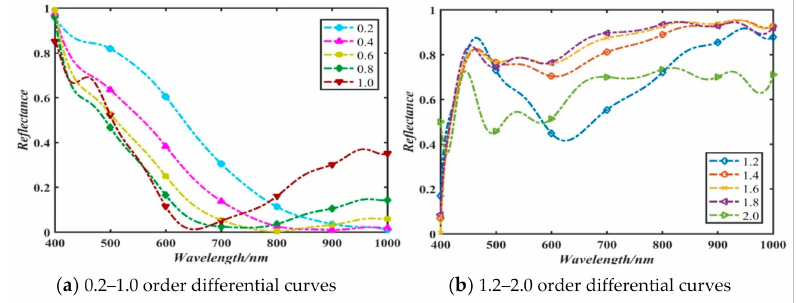
Figure 5. Different order differential processing of spectral